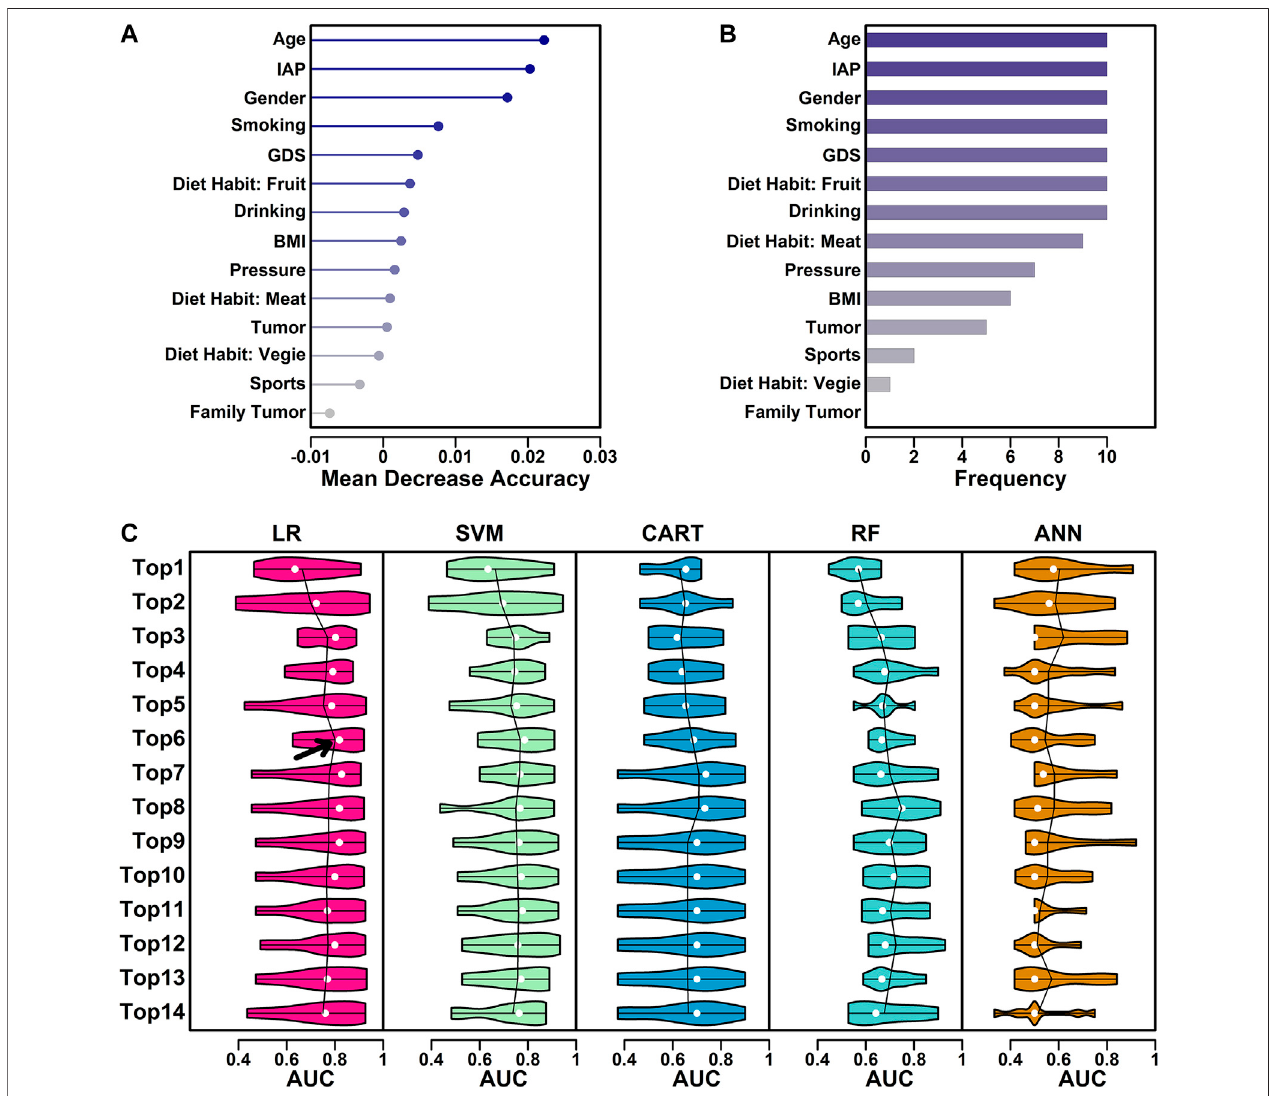
FIGURE 1 | Feature selection process. (A) MDA values of all 15 features. (B) The number of the appearances in top 10 ranked variables in every iteration. (C) Performance of fi ve different algorithms using different combinations of features. The AUC values from 10 iterations were illustrated as violin plot, with mean value highlighted in lines and median value highlighted in white